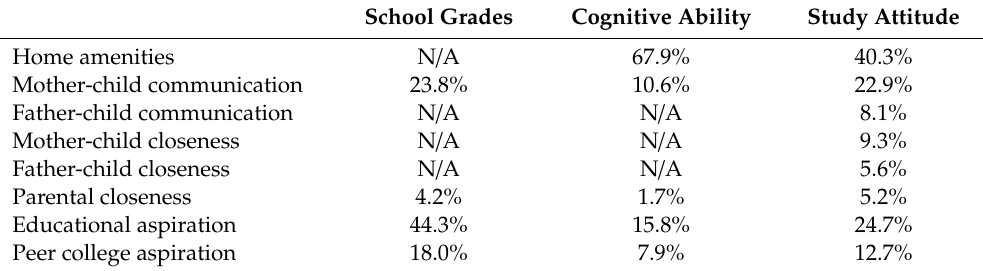
Table 6. Proportions of Total E ff ect